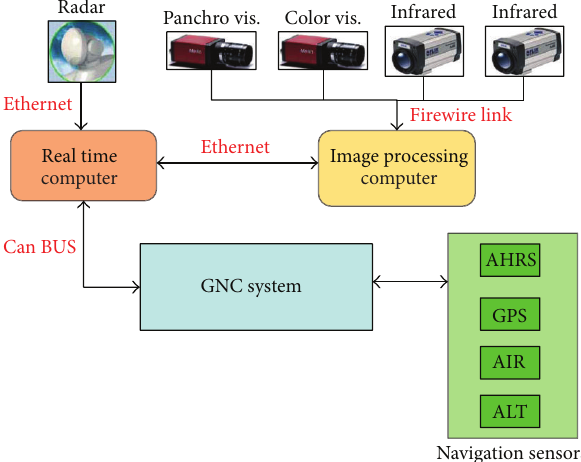
Figure 3: The onboard hardware